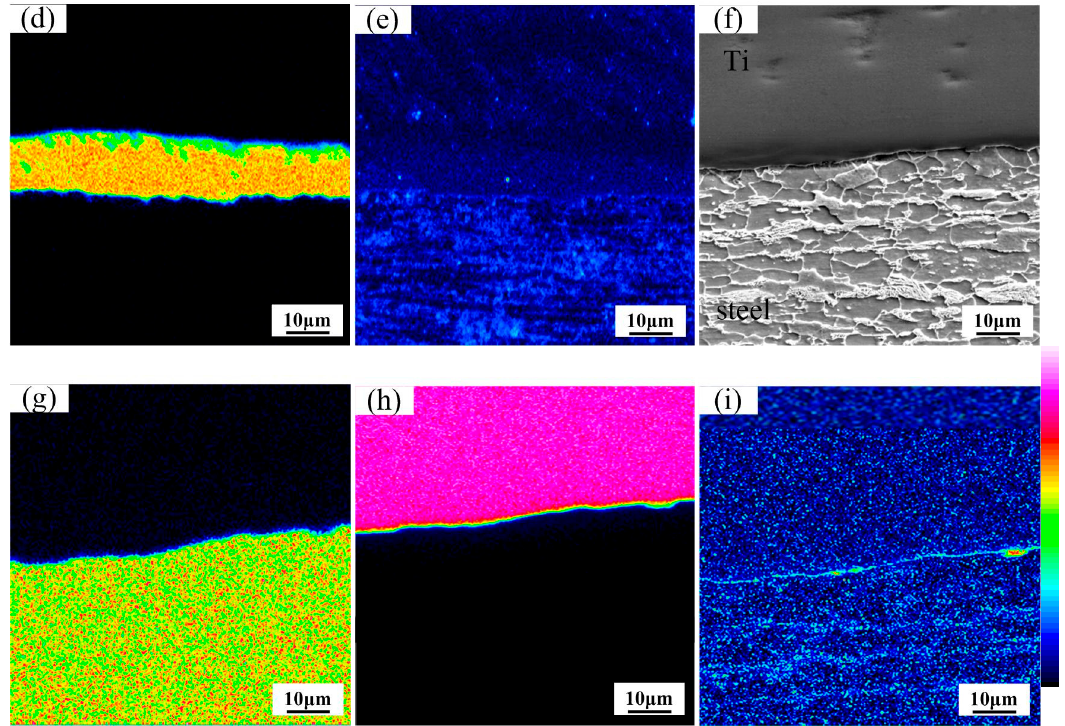
Figure 6. Map distribution micrographs of various elements at the interfaces at 900 °C: ( a ) BSE image; ( b ) Fe element; ( c ) Ti element; ( d ) Nb element and ( e ) C element for Ti/Nb/steel clad plate; ( f ) BSE image; ( g ) Fe element; ( h ) Ti element, and ( i ) C element for Ti/steel clad plate.